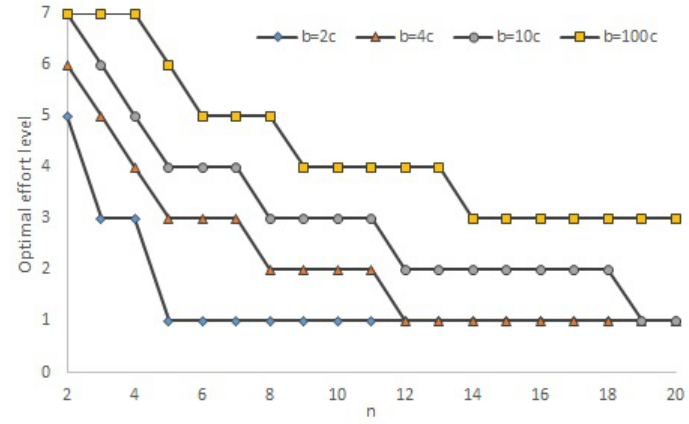
Figure 1. Optimal effort level for fixed q